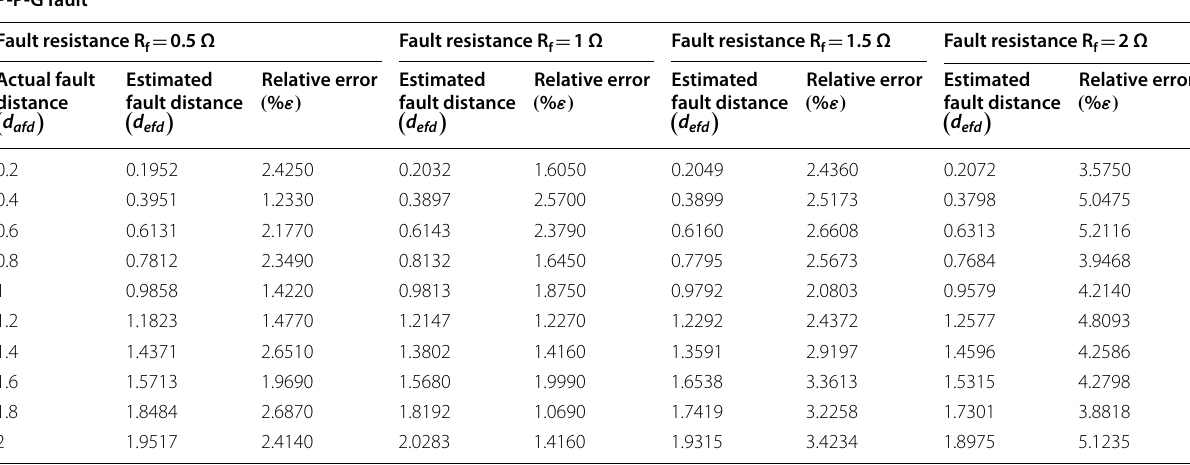
Table 9 P-P-G fault distance estimation by the FF-RLS algorithm P‑P‑G fault Fault resistance R f 0.5 =